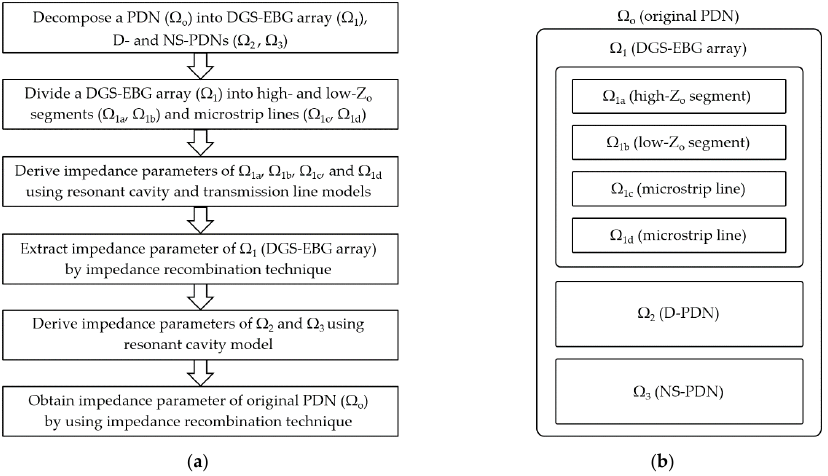
Figure 2. ( a ) Procedure of proposed domain decomposition method for power integrity analysis of EBG-based PDN and ( b ) a domain diagram.